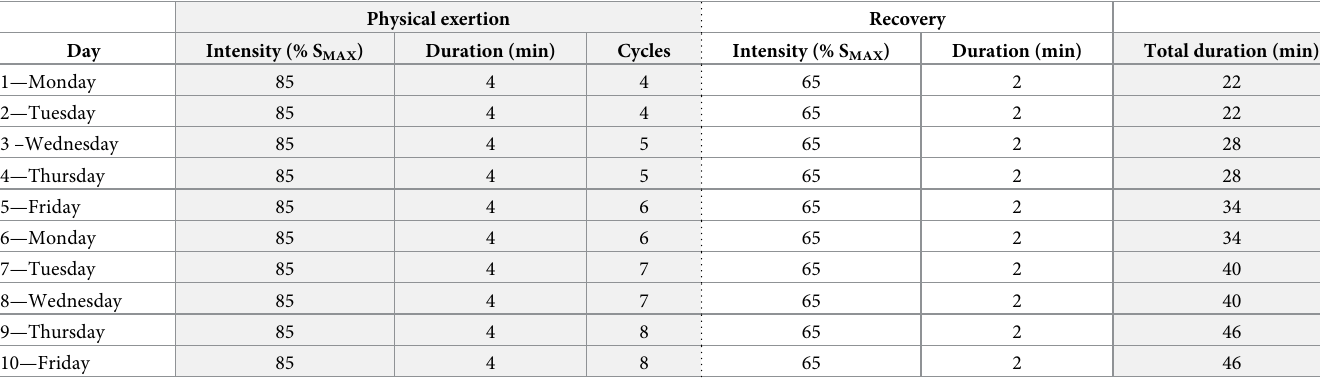
Table 3. Description of training sessions of the HIIT 85%